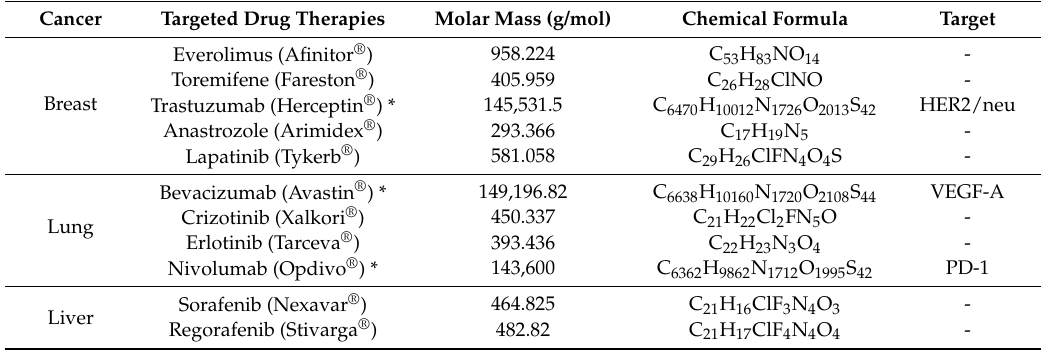
Table 2. Targeted drug therapies that have been approved by the U.S. Food and Drug Administration. Data from the National Cancer Institute